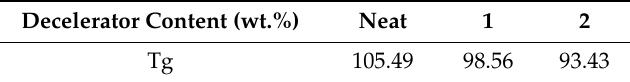
Table 1. Glass transition temperature (Tg) of endo-DCPD and endo-DCPD with decelerators after curing